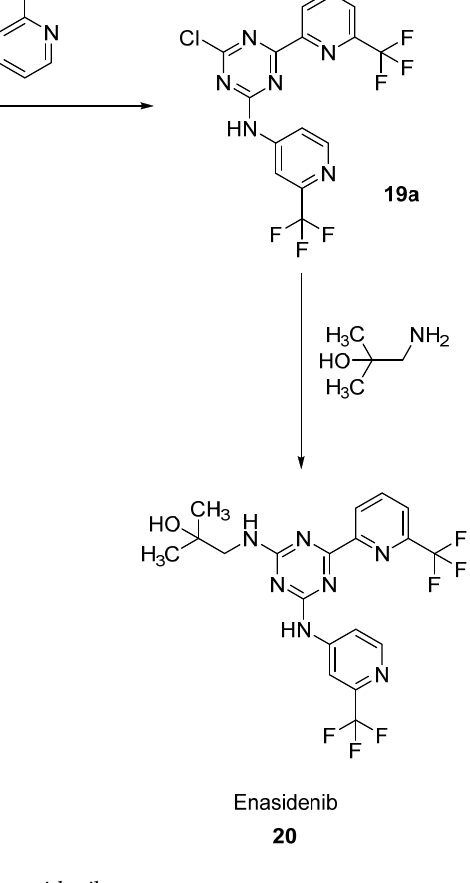
Figure 10. Synthesis and structure of enasidenib.